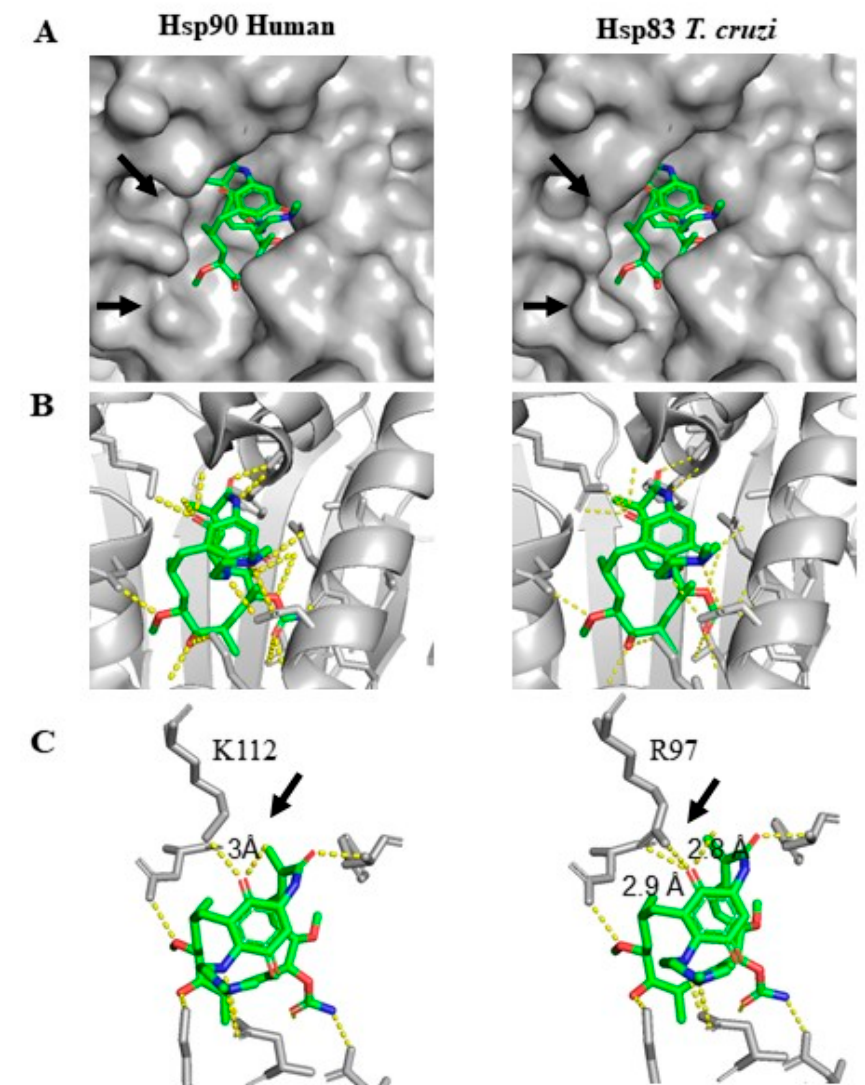
Figure 5. Binding of 17-DMAG to Human Hsp90 and T. cruzi Hsp83. ( A ) Binding pocket surface of Hsp90 ( left ) and Hsp83 ( right ) with 17-DMAG. ( B ) Zoom-in to the residue interactions of Hsp90 ( left ) and Hsp83 ( right ) with 17-DMAG. ( C ) Zoom-in to the K112 residue of Hsp90 ( left ) and R97 residue of Hsp83 ( right ) interaction with 17-DMAG. PyMol software was used for visualizing PDB ref.: 1OSF [32]. 17-DMAG structure is represented in green and protein structure in grey. In panel A, arrows indicate morphological differences between both surfaces. In panel C, arrows show the position of expected H-bonds between 17-DMAG and K112 or R97 residues, respectively. Hsp90/83 from panel B is represented as cartoons; in panel C they are represented as sticks [33].